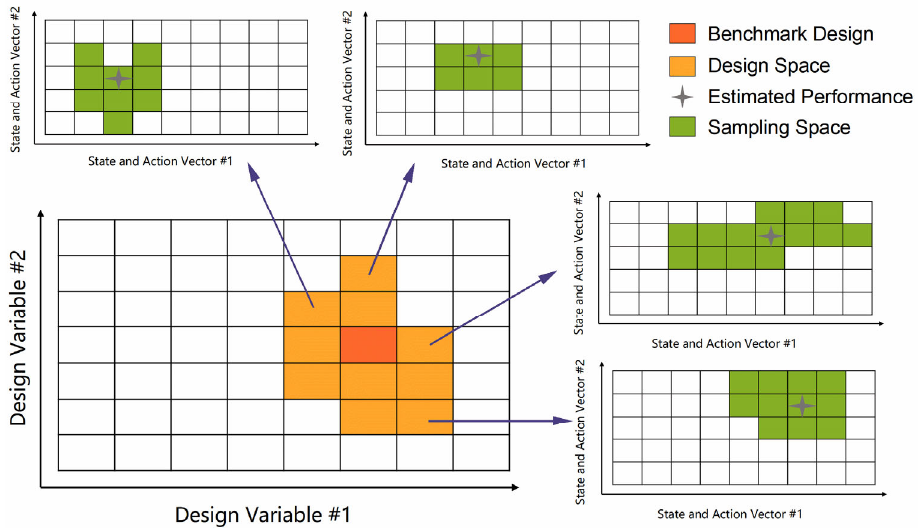
Figure 2. Schematic diagram of samplings of general configuration optimisation of a crewed racing sailboat. The design space of a crewed sailboat is limited. For each design, there is also good enough prior information on performance. Thus, only a relatively small amount of CFD sampling is required.